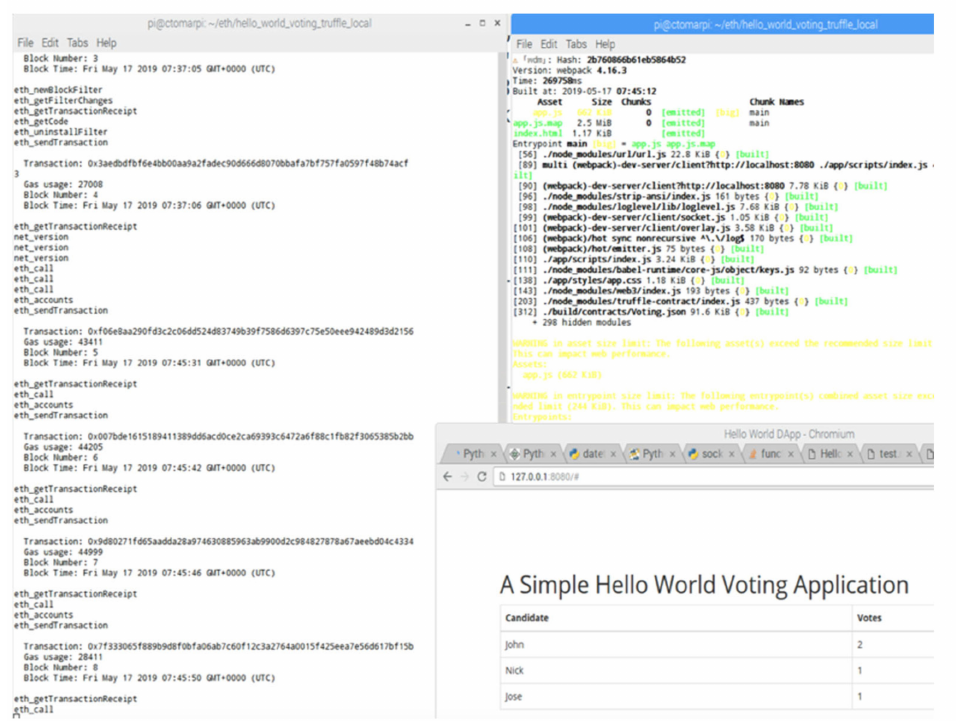
Figure 17. The web interface for displaying the votes number available for access on each IoTeD node of the e-Voting D-App solution, not necessarily involving physical buttons but only the web interface rendered by the embedded web server from the